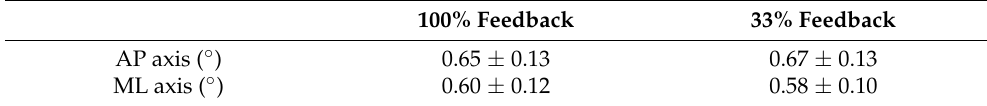
Table 2. Group means ( ± standard deviation) for the vibration threshold along the AP and ML axes.